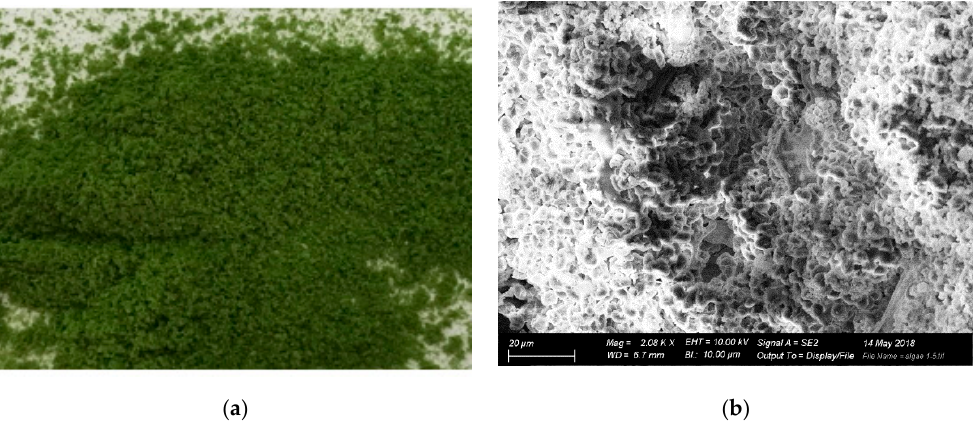
Figure 3. Surface microstructure of C. sorokiniana biomass after lyophilization: ( a ) external view; ( b ) microstructure.